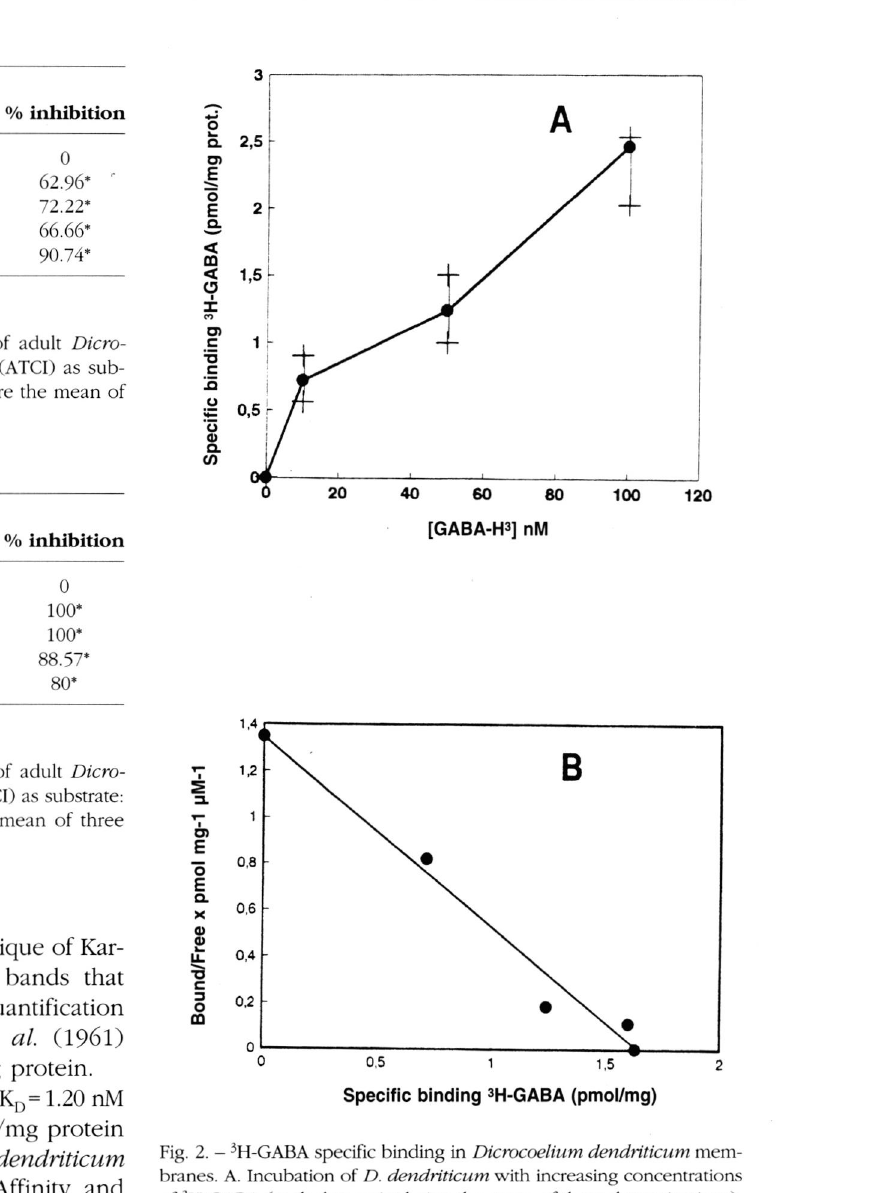
Fig. 2. - 3 H-GABA specific binding in Dicrocoelium dendriticum mem branes. A. Incubation of D. dendriticum with increasing concentrations of 'H-GABA (each data point being the mean of three determinations). B. Scatchard plot of the specific binding data shown in